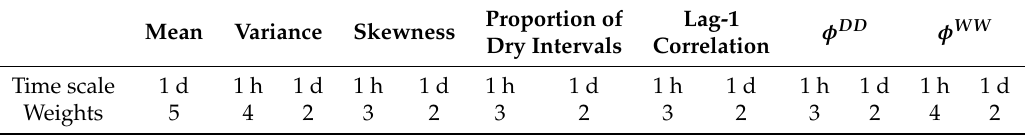
Proportion of Lag-1 φ DD φ WW Dry Intervals Correlation